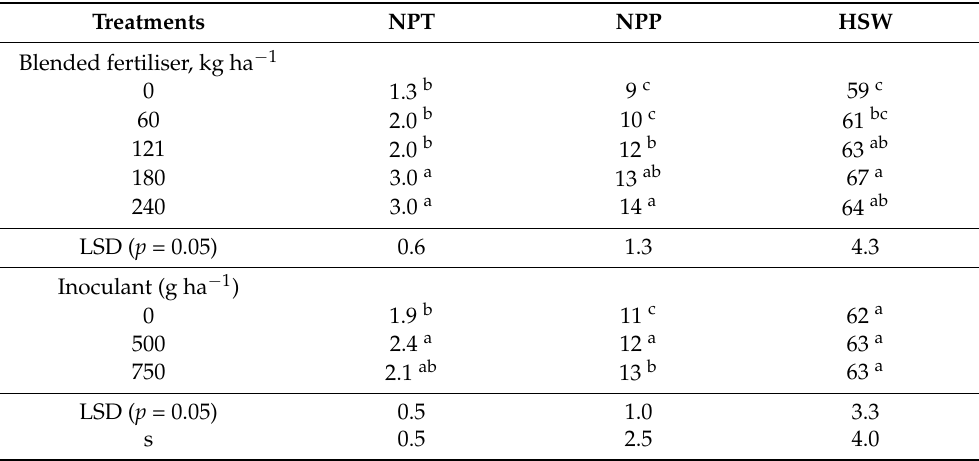
Table 8. Number of productive tillers (NPT), pods per plant (NPP) and hundred seed weight (HSW) influenced by the main effects of the blended fertiliser and the